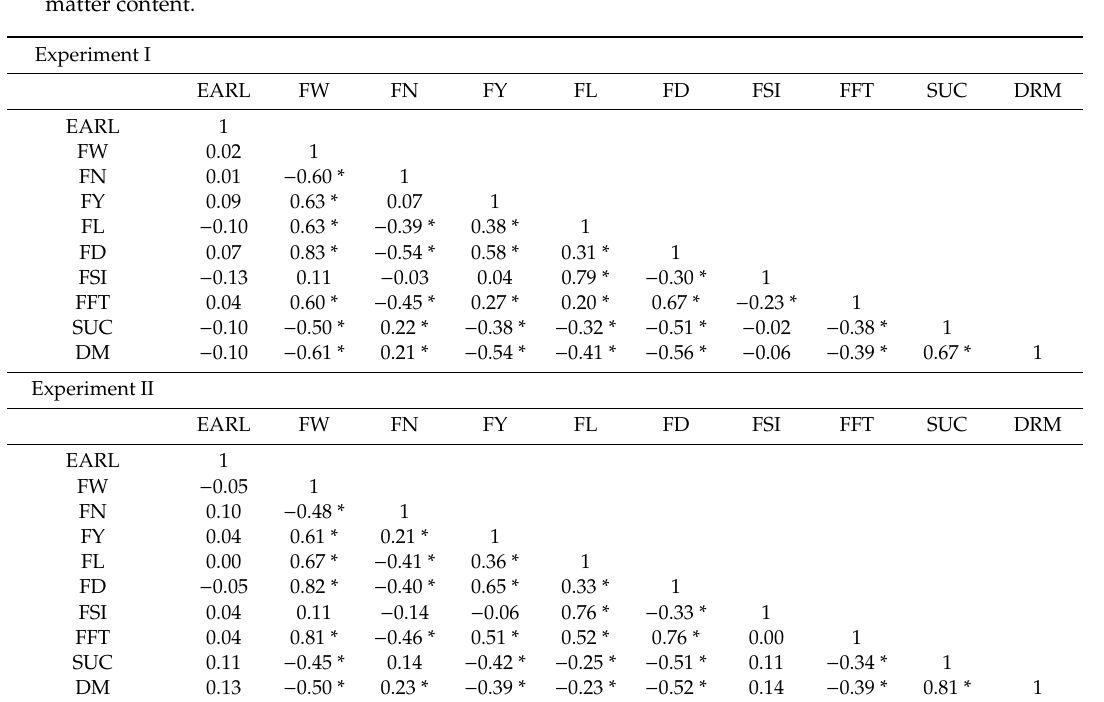
Table 2. Pearson’s correlation coe ffi cient analysis of fruit-related traits in experiments 1 and 2 (Exp I and II). EARL—earliness; FW—fruit weight; FN—fruit number; FY—fruit yield; FL—fruit length;